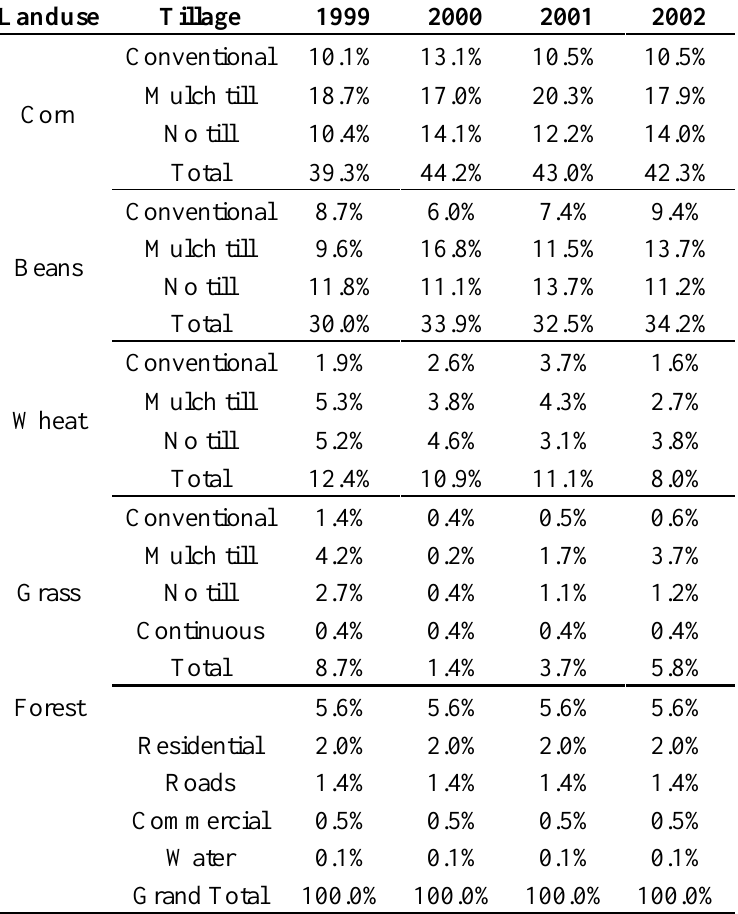
Table 2. Upper Auglaize watershed 4-year crop, tillage, and land-use distribution in percent, the total area is 85,812